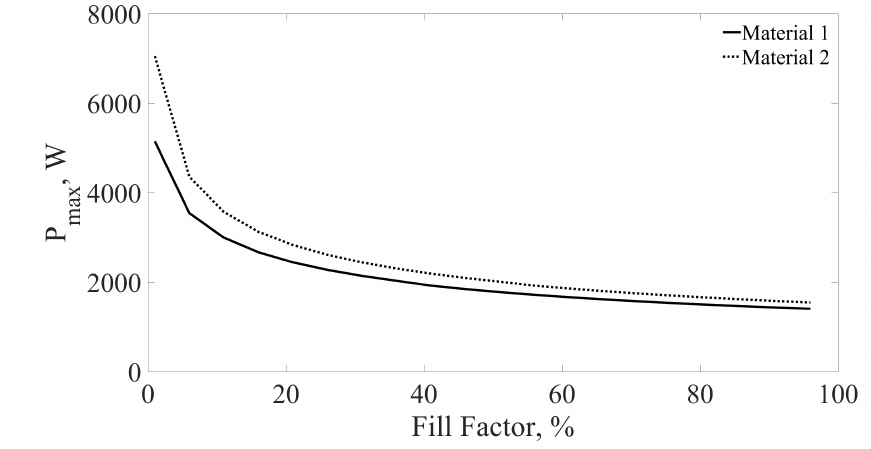
Figure 12. Maximum possible power generation per combustion chamber as a function of the TEG fill factor, for the values of L opt presented in Figure